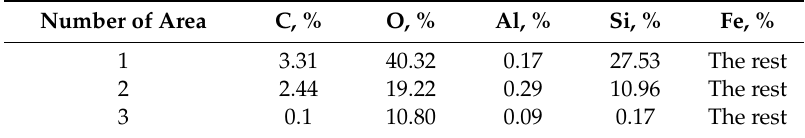
Table 8. The SEM analysis results of the worn surface of optimal composition MMC (Figure 16d, areas